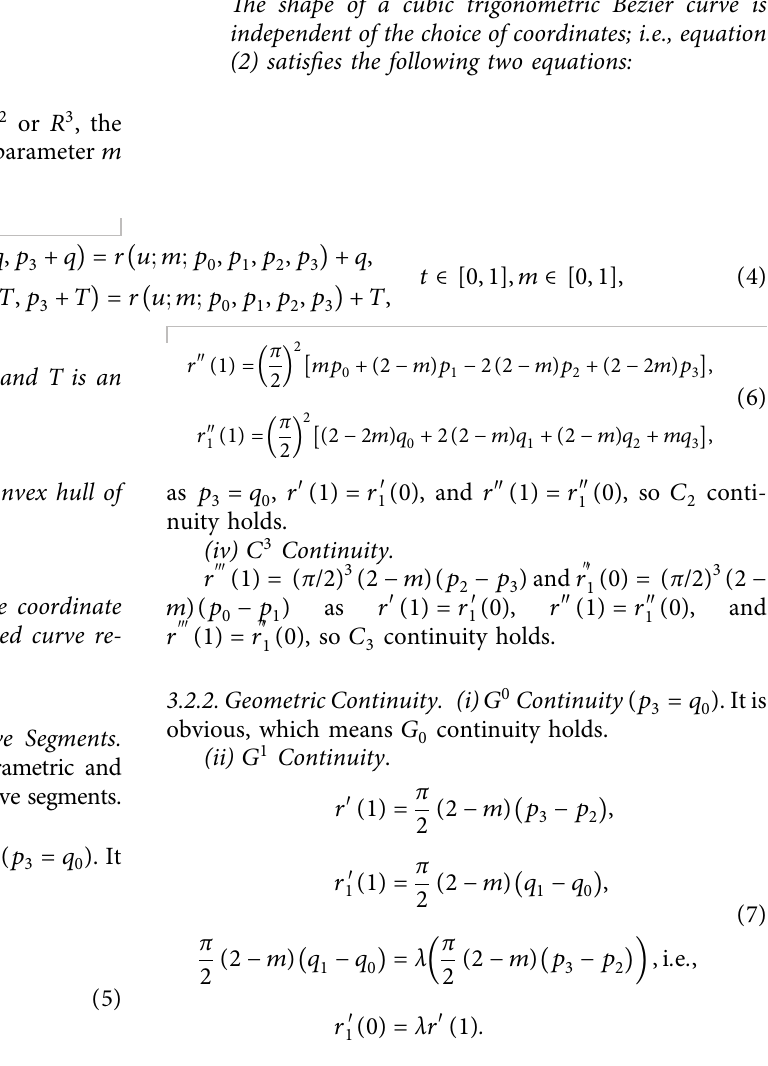
Figure 1: Cubic trigonometric functions with different shape